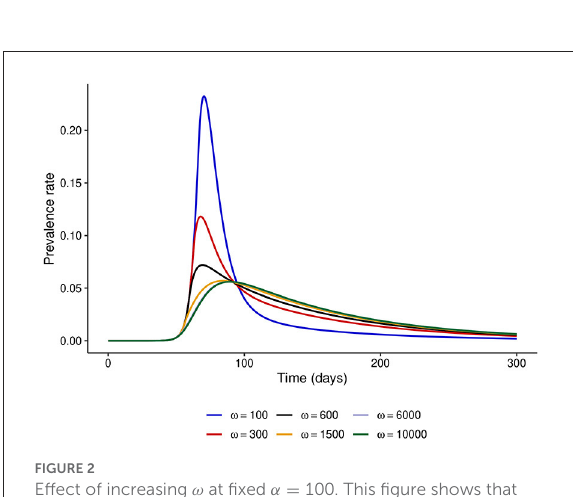
FIGURE2 Effect of increasing ω at fixed α = 100. This figure shows that when the level of public tolerance for the disease is high, the prevalence at the peak of the epidemic can be much higher than what might be expected under the fixed NPI adherence level